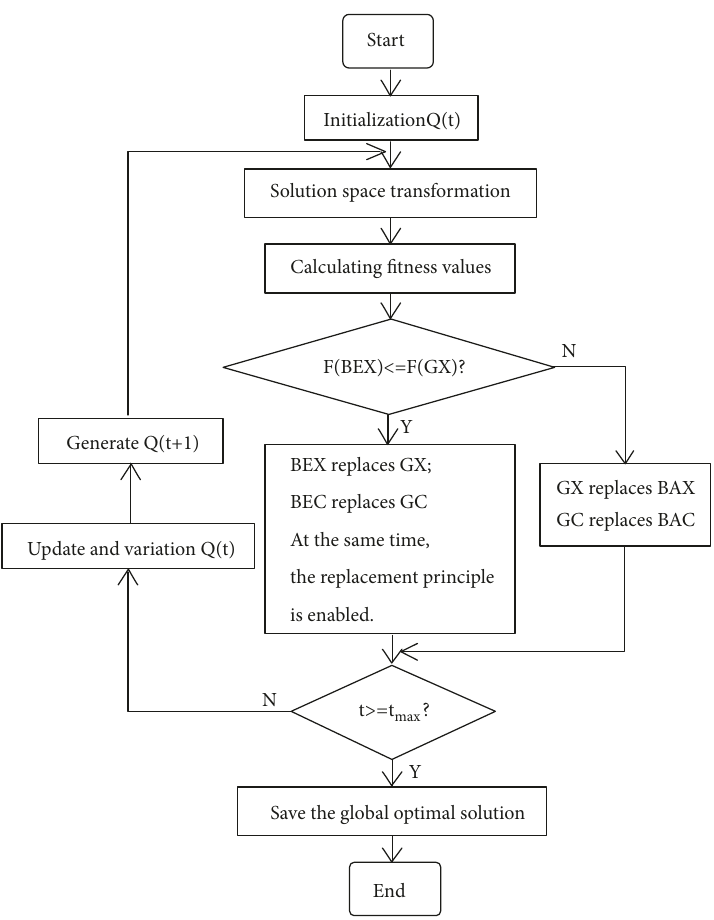
Figure 1: Flow chart for finding inverse kinematics. where, as for calculating the fitness value with the evaluation function F , the smaller F is, the greater fitness is; GX and GC represent the global optimal solution and the global optimal chromosome, respectively.